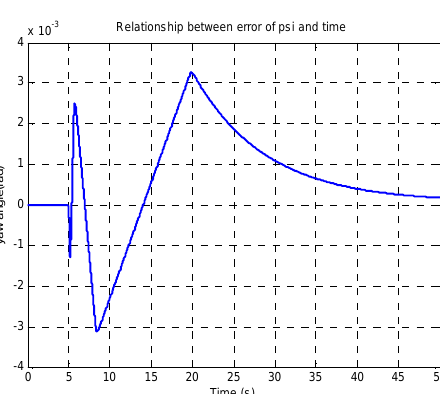
Fig.18.Results of error of ψ for